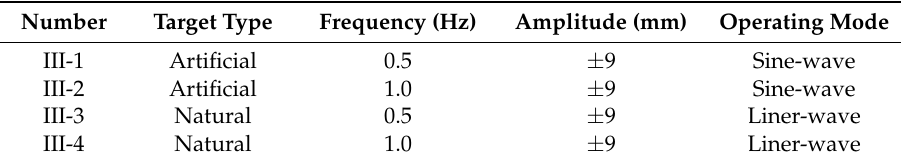
Table 7. Experimental parameters of higher frequency vibration tests.